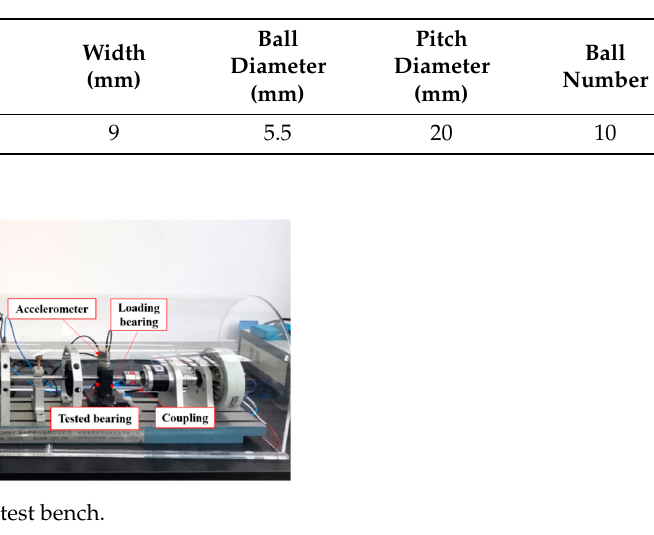
Figure 10. The bearing parameters are shown in Table 2. The sample frequency was set as 20 kHz, and the rotational speed was set as 1300 r/min. Here, f BPFO = 66.535 Hz and f BPFI = 106.799 Hz; D = 0.01, and the re-scaling ratio was set as R = 4000. Table 2. Parameters of bearing 6200-NR NSK.